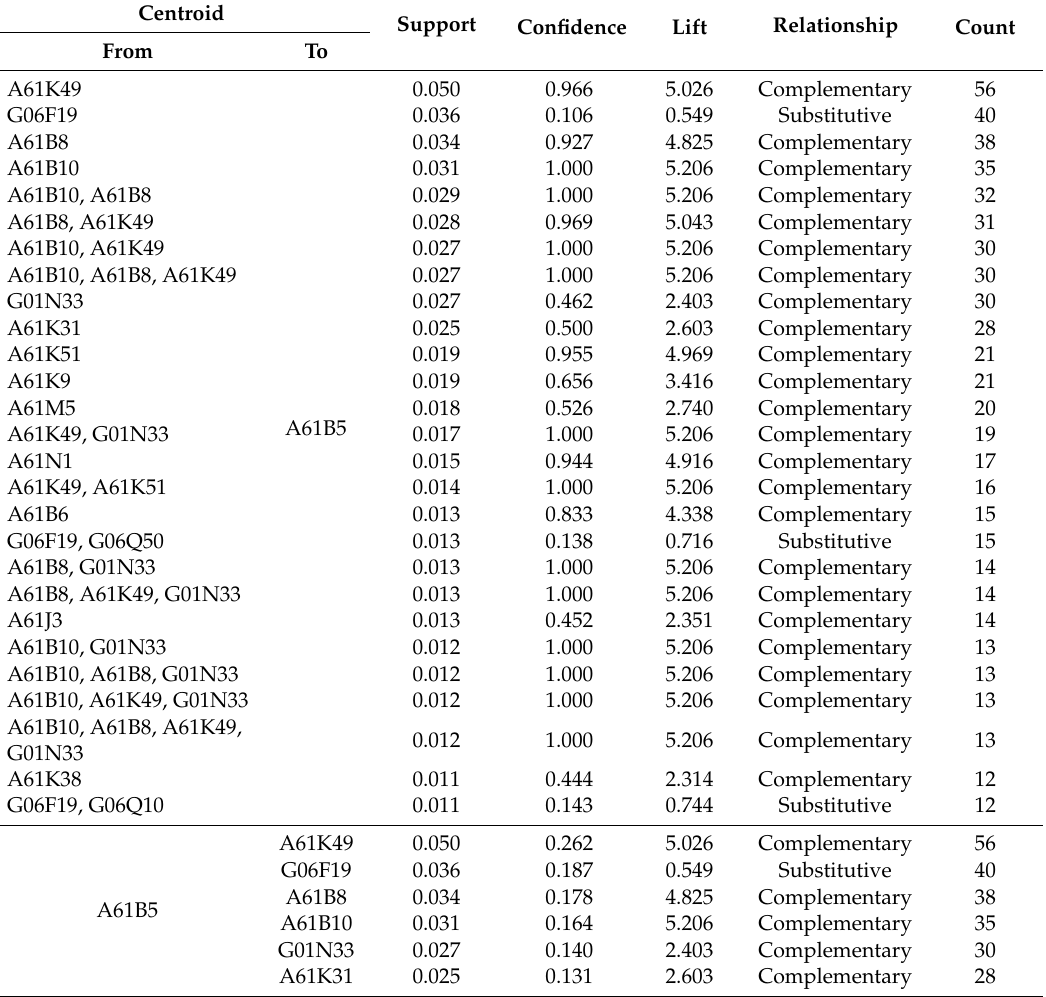
Table A4. Relationships of clusters in the data science-based pharmaceutical innovation period